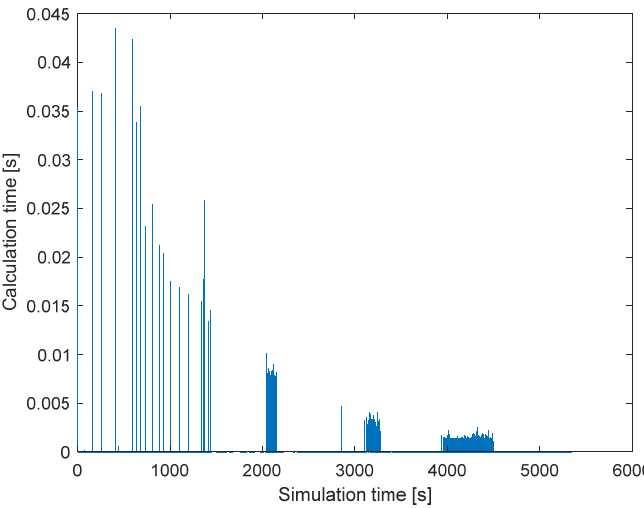
Figure 5. Calculated time-consuming curve in each step.